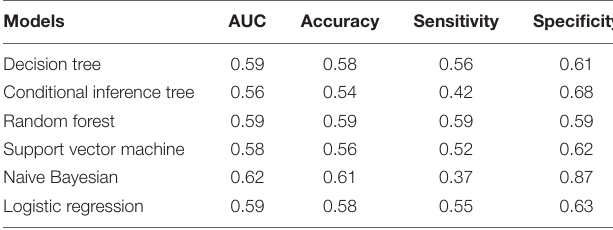
TABLE 2 | Algorithm models of miR-433 and miR-133b for PD prediction.